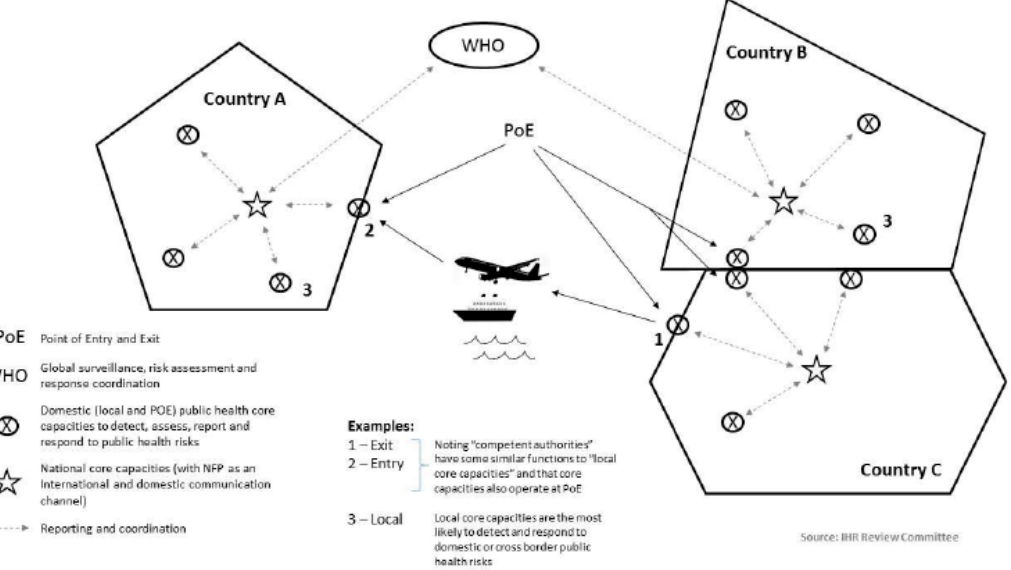
Figure 1: IHR schema depicting the role that national core capacities would play in containing the emergence of a novel infectious disease (World Health Organization, 2016a, p.